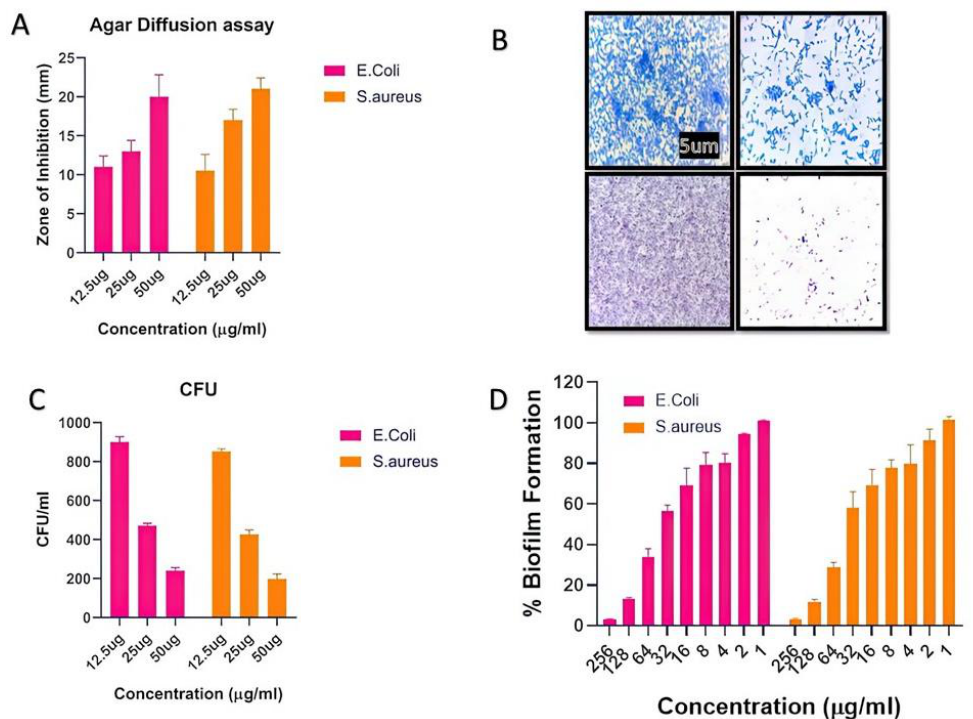
Figure 3. The depiction of the effect of silver nanomaterials on the bacterial growth. The ( A ) inhibition zone observed in the agar diffusion assay. ( B ) Crystal violet staining to study biofilm formation in the presence of nanomaterials, and ( C ) the colony-forming unit decreased with the increasing dose of nanomaterials. ( D ) The percent of the biofilm inhibitory effect with the increasing dose of nanomaterials.